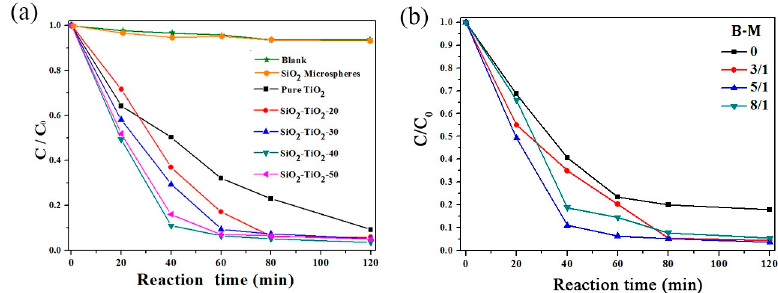
Figure 1. Influences of ( a ) TiO 2 ratio and ( b ) B-M ratio on the photocatalytic performance of SiO 2 –TiO 2 . ( a ) SiO 2 –TiO 2 -20, 30, 40, 50 represent the mass ratio of TiO 2 to SiO 2 –TiO 2 is 20%, 30%, 40% and 50%; and ( b ) B-M represents the mass ratio of grinding balls to the materials.